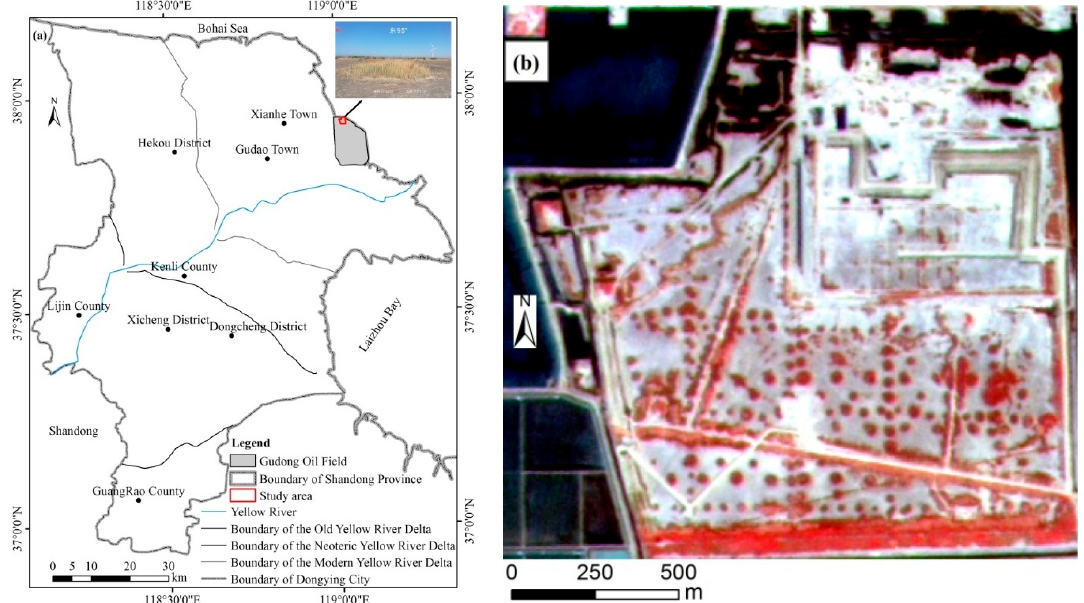
Figure 1. ( a ) Map showing the location of the study area in Dongying City, Shandong Province, China (photograph taken on 30 May 2018); ( b ) Subset of the CBERS-04 fusion imagery (18 May 2017) acquired over the study area shown as a false color RGB composite consisting of R-Near infrared (band 4), G-Red (band 3), and B-Green (band 2).